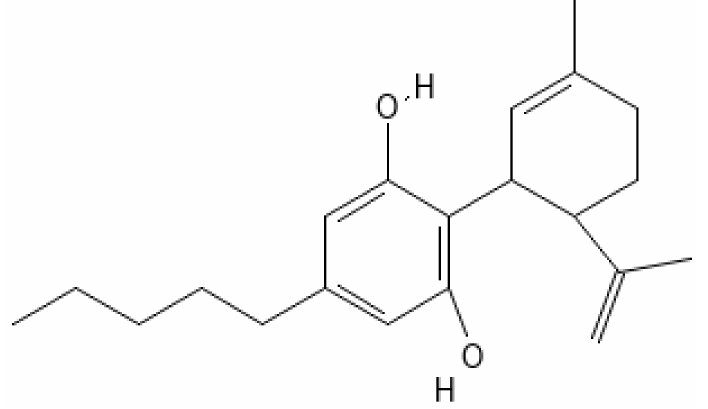
Figure 1. Chemical structure representation of CBD. Image obtained by Pubchem (https://pubchem. ncbi.nlm.nih.gov/compound/644019, accessed on 23 July